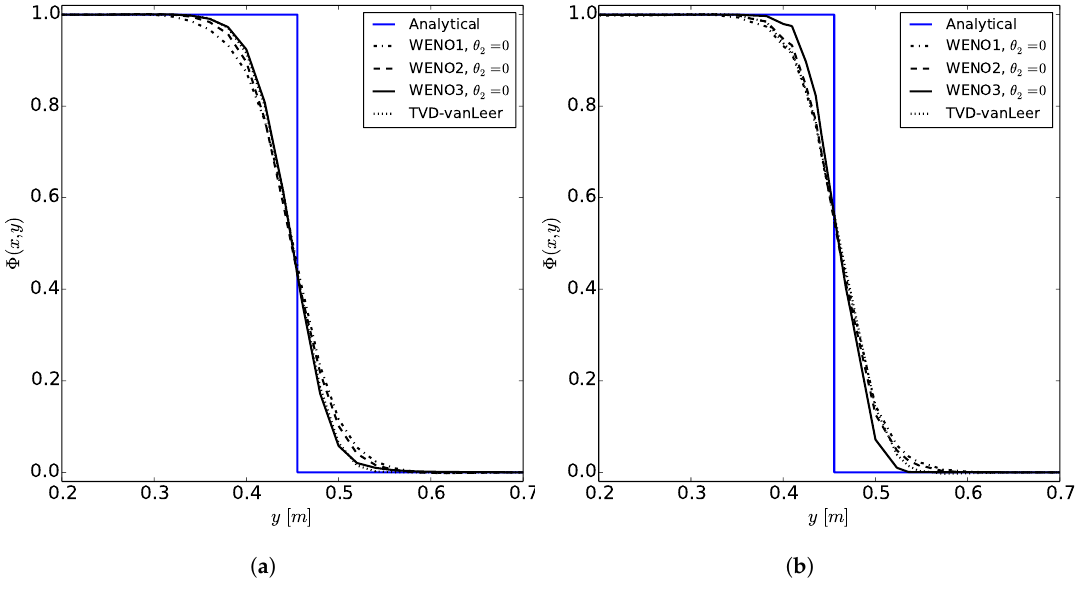
Figure 13. Slice of the step -profile at x = 0.5 m. ( a ) 2500 squares; ( b ) 2832